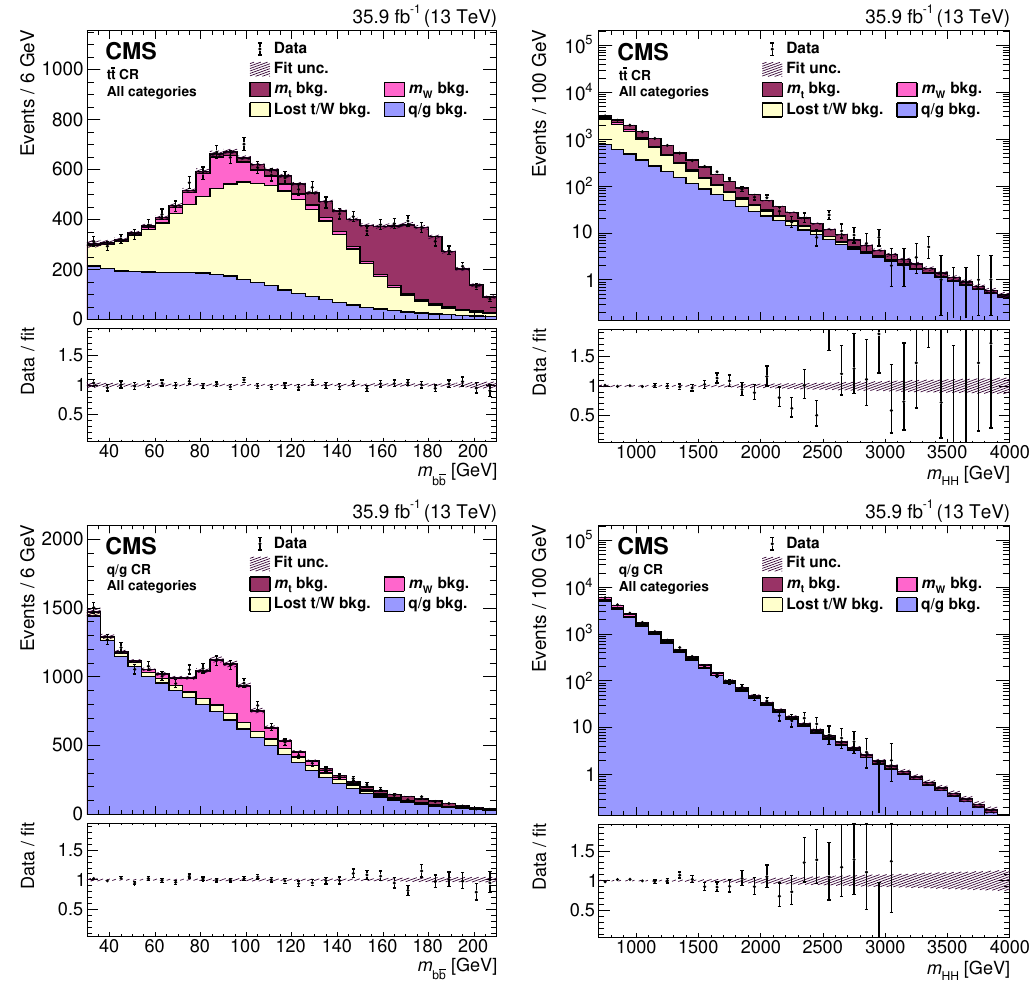
Figure 2 . The (cid:12)t result compared to data in the tt CR (upper plots) and q = g CR (lower plots), projected in m (left) and m (right). Events from all categories are combined. The (cid:12)t result HH bb is the (cid:12)lled histogram, with the di(cid:11)erent colors indicating di(cid:11)erent background categories. The background shape uncertainty is shown as the hatched band. The lower panels show the ratio of the data to the (cid:12)t